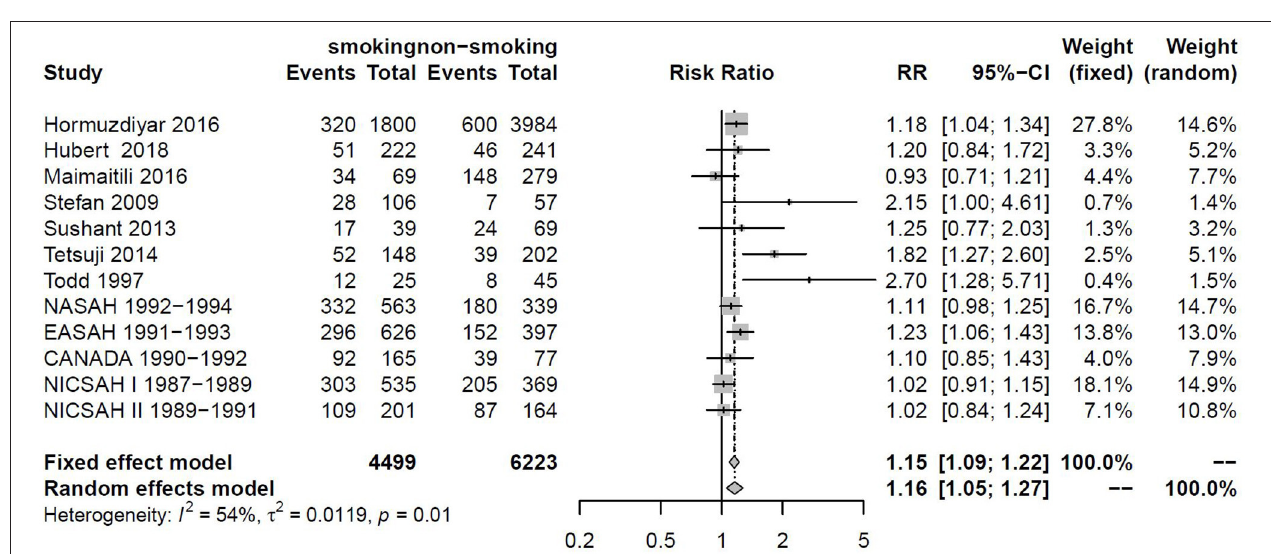
FIGURE 1 | Flow diagram of literature search and selection of included studies for meta-analysis.